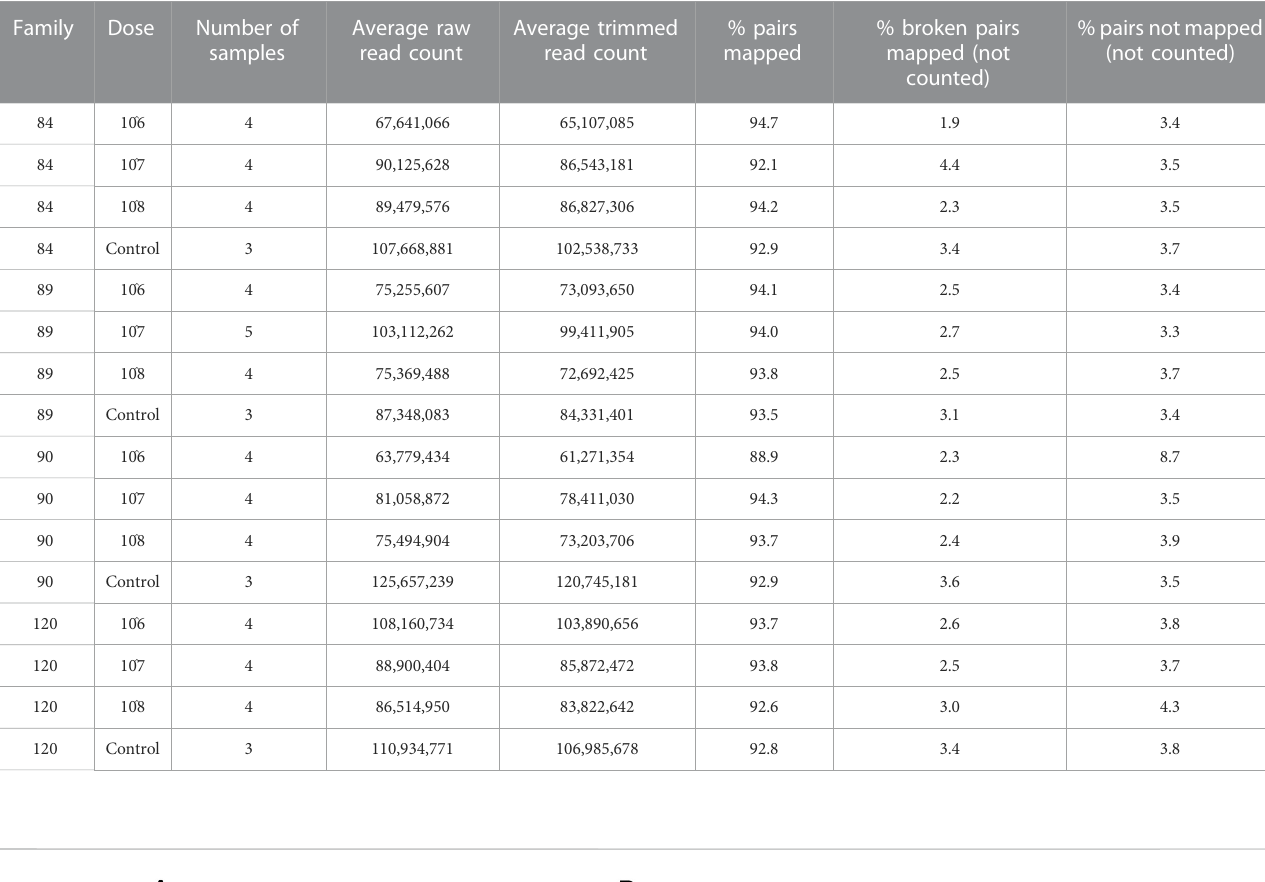
TABLE 1 Sequencing and mapping statistics by group.